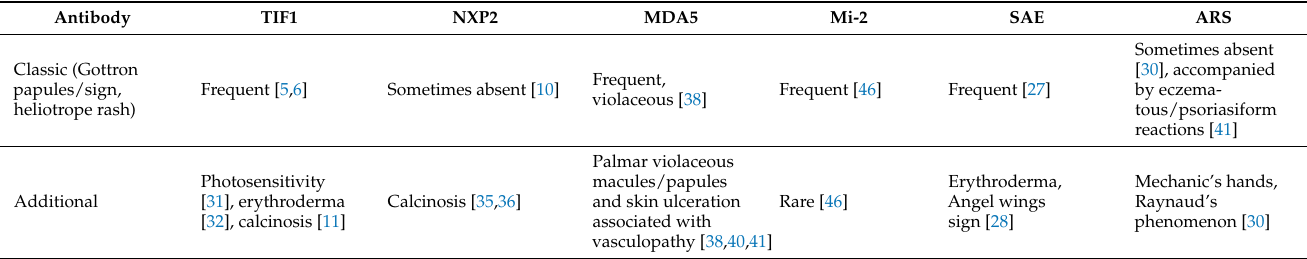
Table 2. Cutaneous manifestations characterized by myositis-specific